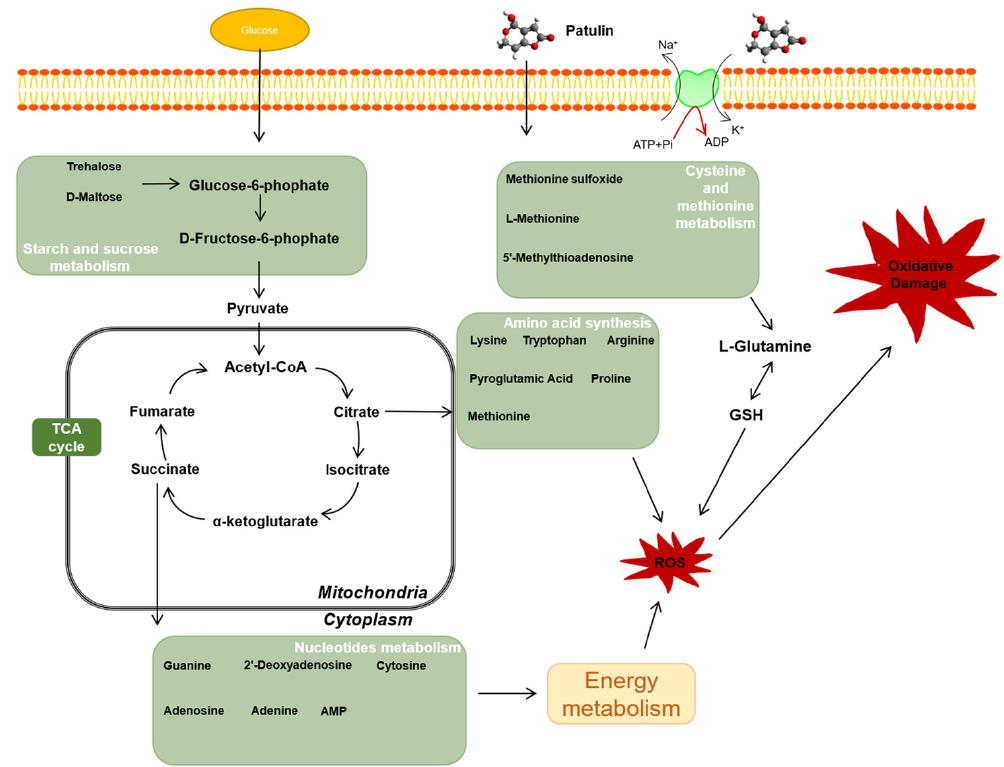
Figure 9. Model for the response of L. plantarum CCFM1287 to PAT exposure using the metabolome.